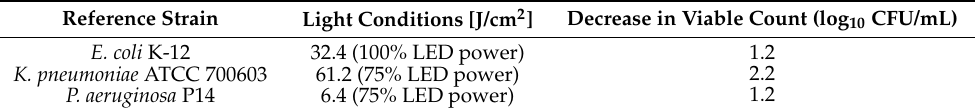
Table 1. aBL treatment conditions.